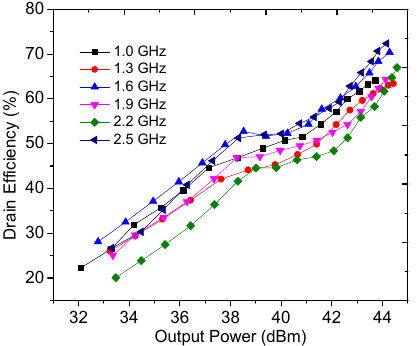
Figure 13. Completed DPA circuit with distributed parameters.